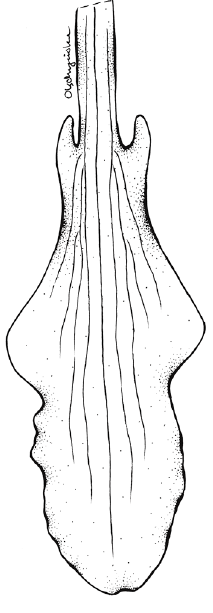
Figure 7. Lip of Schiedeella crenulata—drawn from the holotype (Forderstrom 2592, deposited at AMES). Drawn by N. Ol ę drzy ń ska. Table 3. Summary of the morphological differences between Schiedeella bajaverapacensis and genetically related S. crenulata .